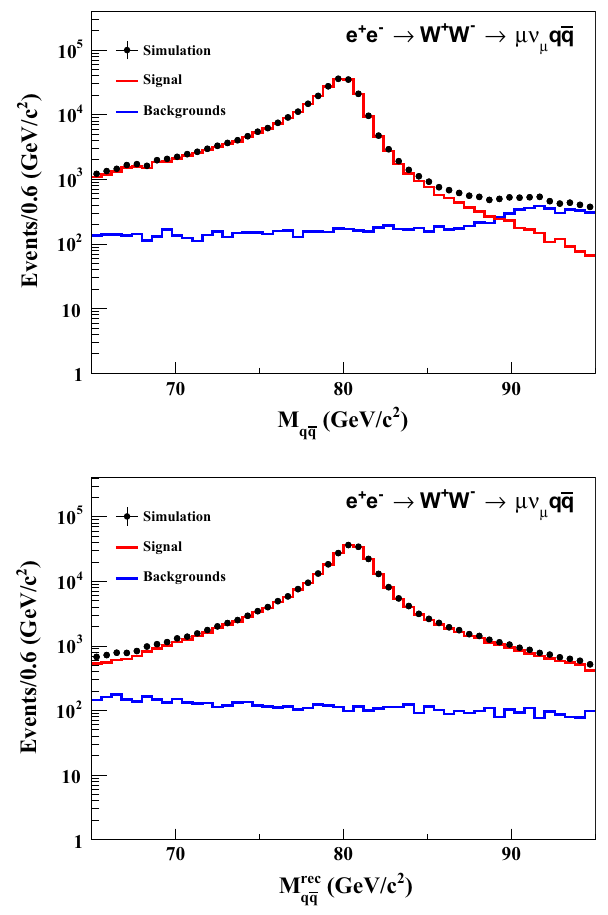
Fig. 3 The invariant and recoil mass of two jets of e + e − → W + W − → μν μ q ¯ q process. The black dots are the distributions of MC simulated SM processes, while the red and blue histograms are for signal and background processes, respectively